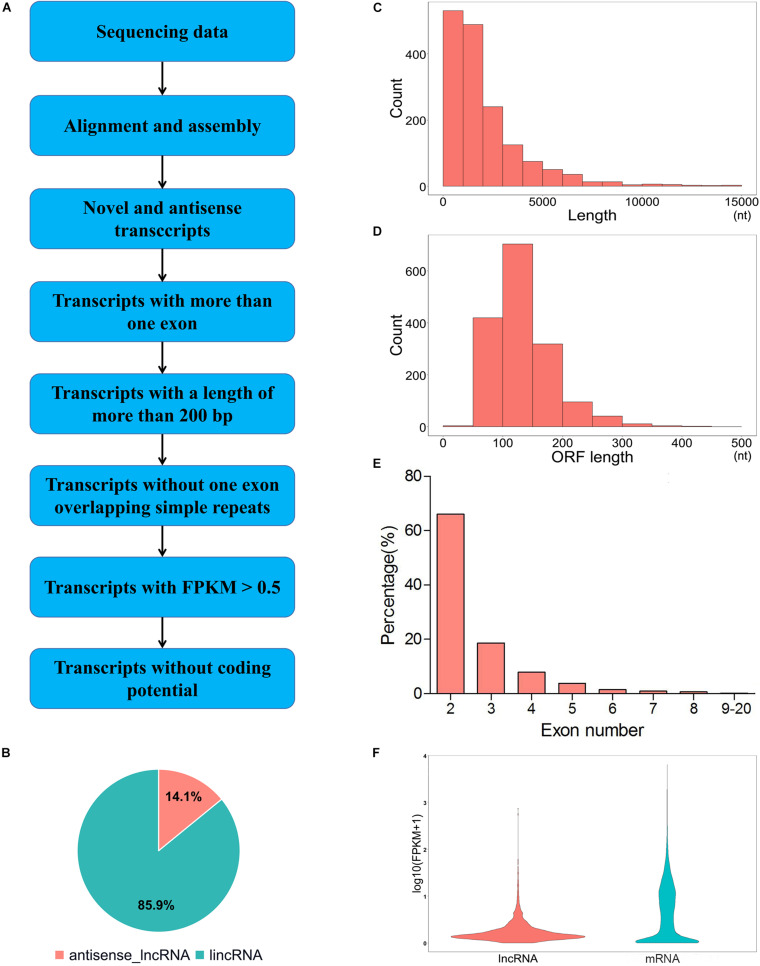
Generation and characterization of lncRNAs in mammary gland of yak. (A) Pipeline for identification of lncRNAs. (B) Classification of lncRNAs. (C) The length distribution of lncRNAs. (D) ORF length distribution of lncRNAs. (E) Exon number distribution of lncRNAs. (F) Expression level of lncRNAs and mRNAs. Red and blue represent lncRNAs and mRNAs, respectively.